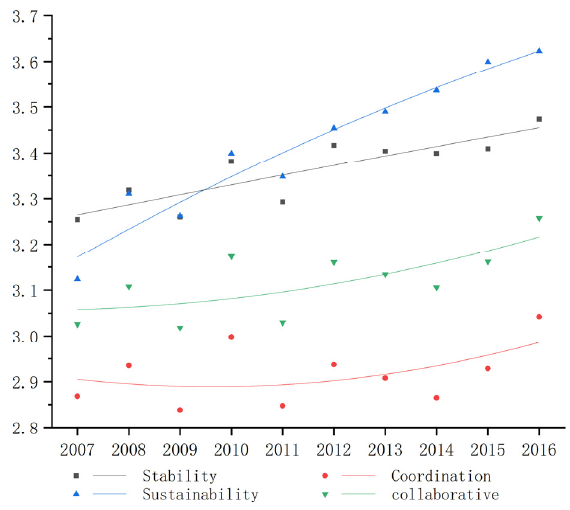
Figure 3. National collaborative security index from 2007 to 2016.